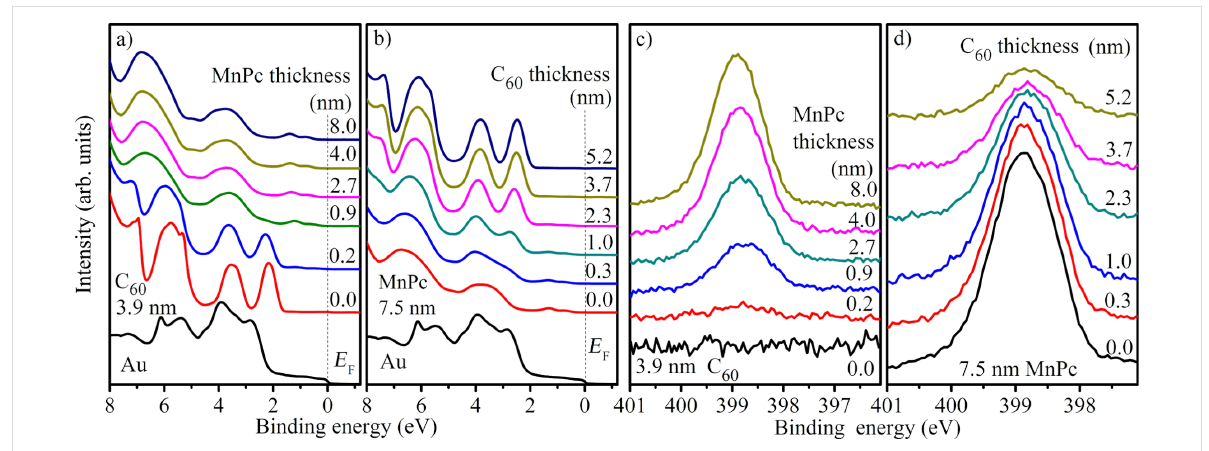
Figure 1: Evolution of the valence-band PES data (He I α ) as a function of a) MnPc deposition onto C 60 and b) C 60 deposition onto MnPc. Additionally, the bottom spectrum represents the freshly prepared Au(100) surface. N1s core-level data of MnPc as a function of c) MnPc deposition onto C 60 and d) C 60 deposition onto MnPc. The corresponding layer thicknesses are